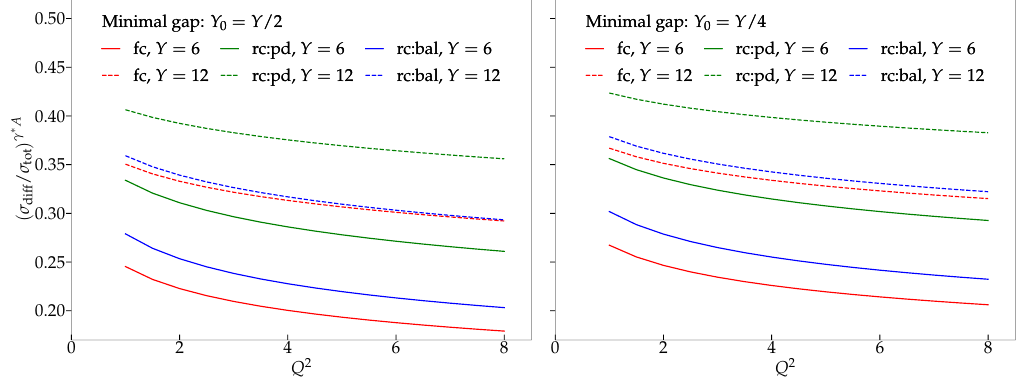
Figure 1: The diffractive fraction for two different values of the minimal rapidity gap Y and two values of the total rapidity Y as a function of the virtuality Q 2 . A = 208 0 is set for the nuclear mass number.